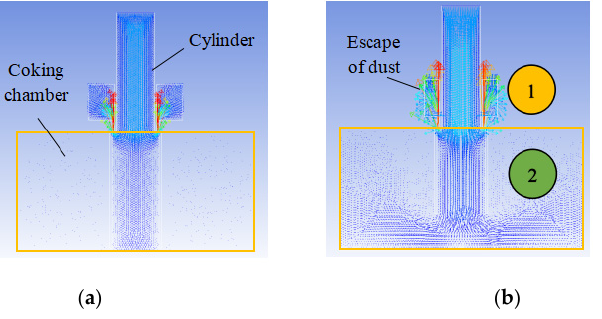
Figure 11. Simulation of dust escape and distribution position with new charging. ( a ) The process of filling the cylinder with coal; ( b ) The process of filling the chamber with coal during the cylinder lifting.